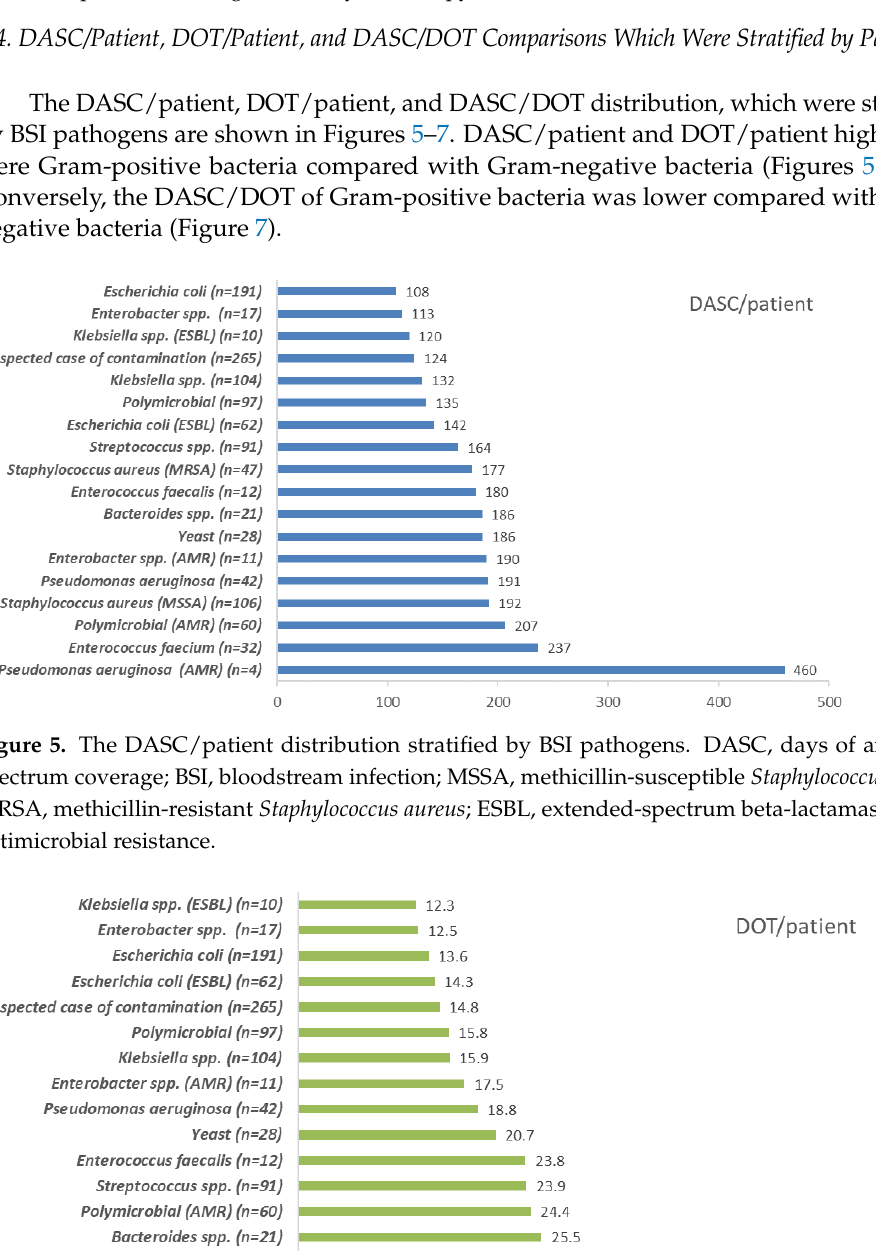
Figure 4. The scatterplot among DASC, DASC/patient, DOT, DOT/patient, DASC/DOT, and the number of patients per month. The x - and y -axes indicate each metric, while the plots indicate each month’s observed values. Diagonal cells show Spearman’s correlation analysis results. A strong cor- relation was observed between DASC and DOT (ρ = 0.963) as well as DASC/patient and DOT/patient (ρ = 0.923). In contrast, DASC/DOT had no correlation with other metrics (ρ = −0.279–0.368). DASC, In contrast, DASC/DOT had no correlation with other metrics ( (cid:36) = − 0.279–0.368). DASC, days of days of antibiotic spectrum coverage; DOT, days of therapy. antibiotic spectrum coverage; DOT, days of therapy.